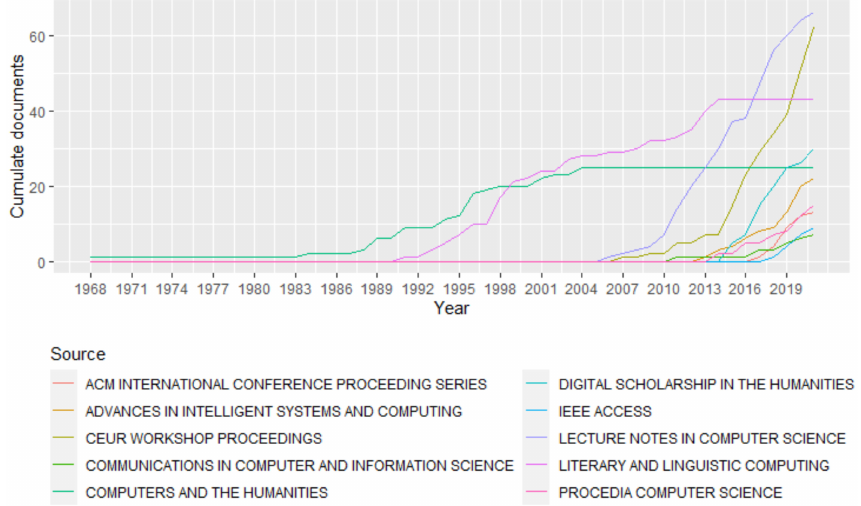
Figure 3. Dynamics of the content related to the subject from different scientific